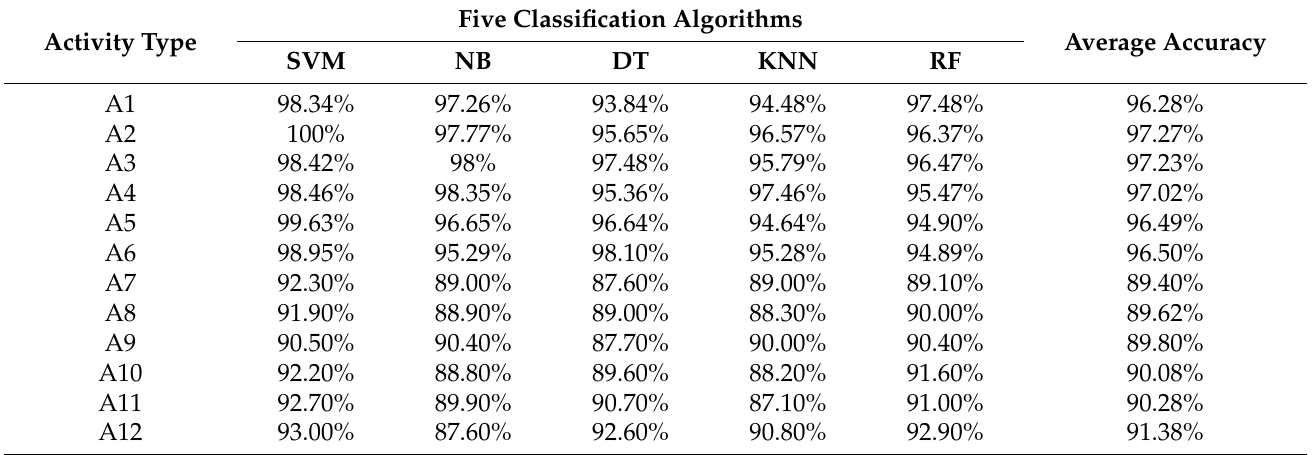
Table 3. The accuracy of different